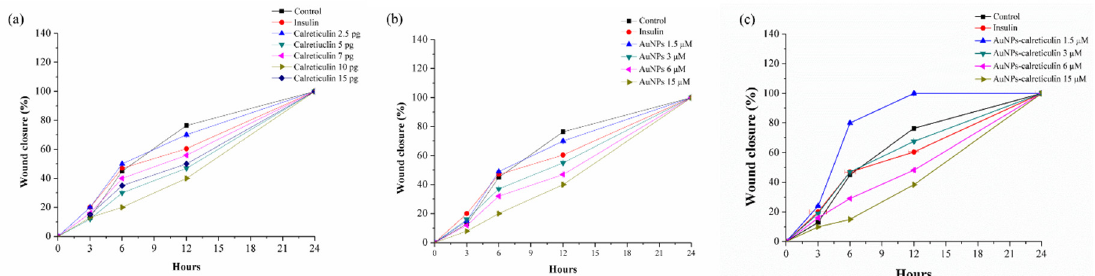
Figure 9. Wound healing assay. Percentage of wound closure in mouse fibroblast cells (NIH/3T3). ( a ) Cells treated with calreticulin, ( b ) cells treated with AuNPs and ( c ) cells treated with AuNPs-calreticulin. Low concentrations of AuNPs-calreticulin showed wound closure faster than other treatments (calreticulin and AuNPs).